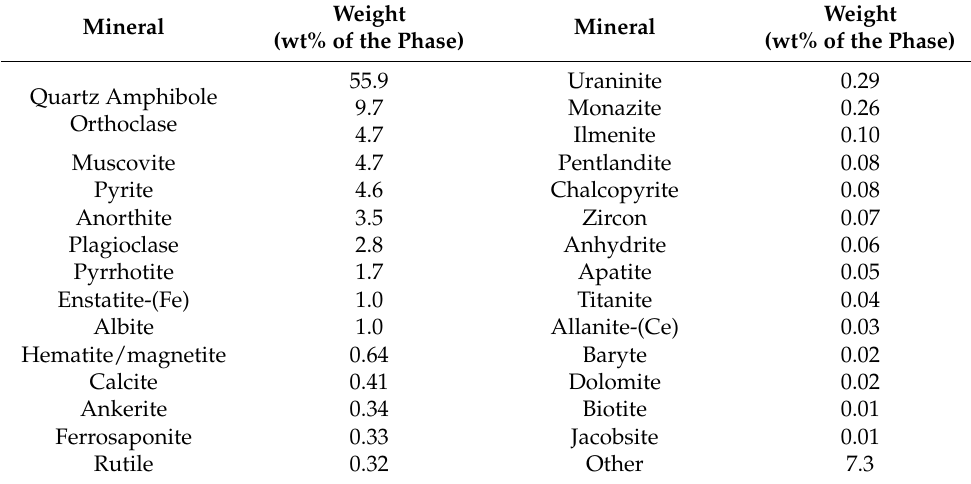
Table 4. Mineral phases quantified by TESCAN Integrated Mineral Analyzer (TIMA) analysis.